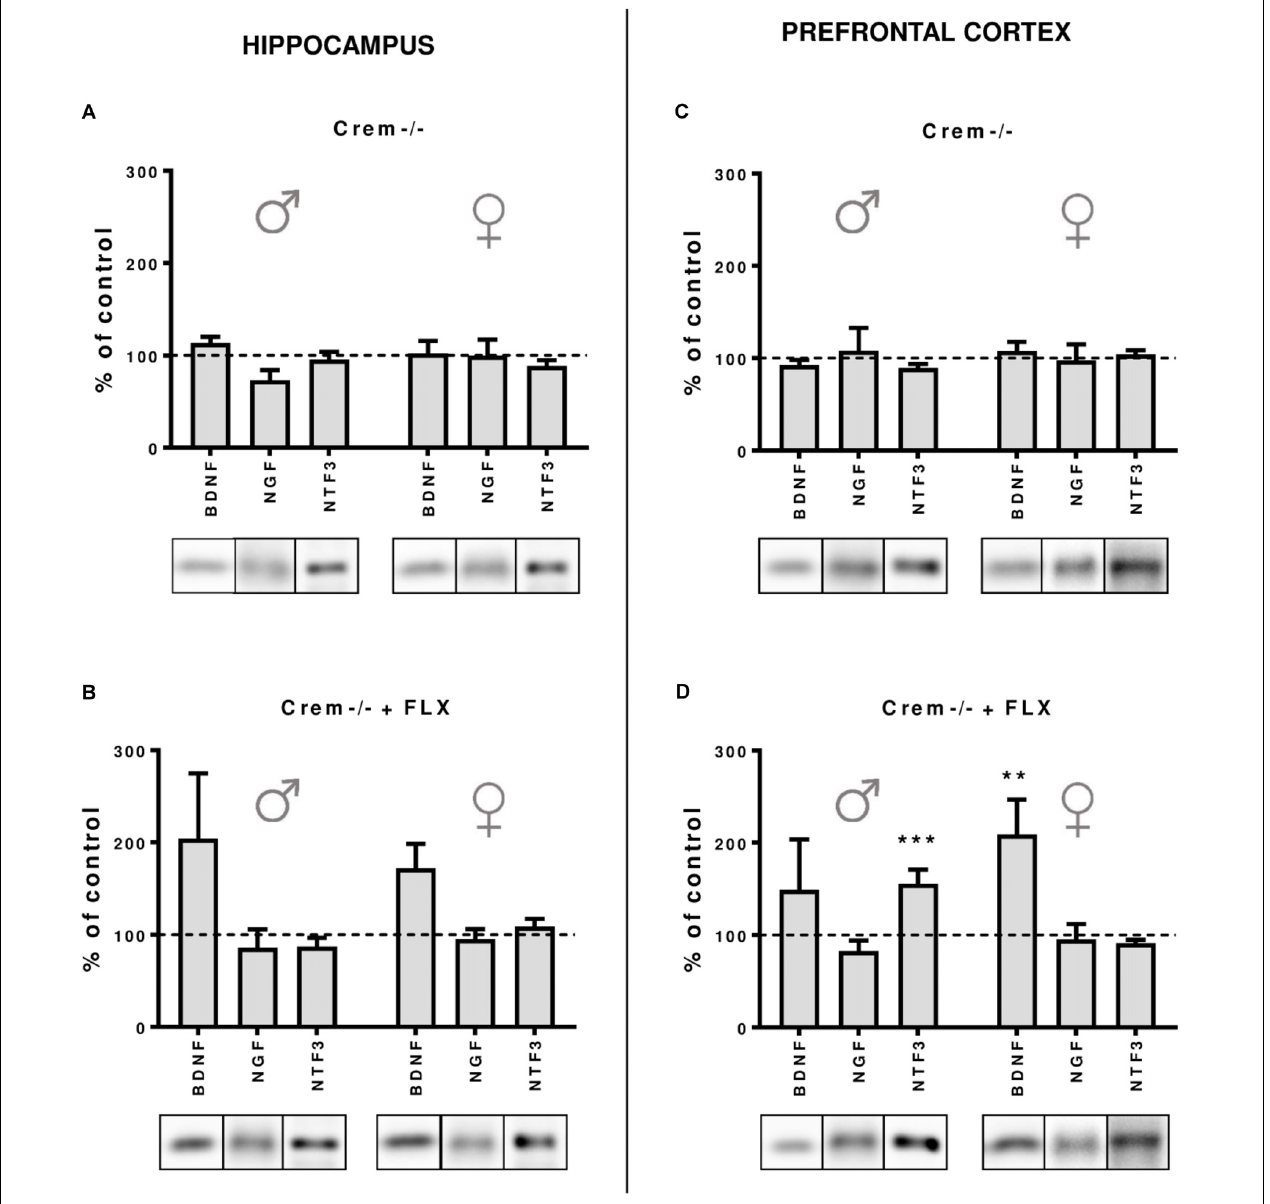
FIGURE 6 | Protein expression of BDNF, NGF and NTF3 after chronic fluoxetine administration in the hippocampus and PFC of wild-type and Crem–/– mice. CREM deletion did not cause any changes in neurotrophin levels in the hippocampus (A) or in the PFC (C) of male and female mutants. Fluoxetine administration increased BDNF levels in the PFC of females ( p < 0.01) (D) , and a similar tendency was observed in the hippocampus of both Crem–/– males and females. Additionally, fluoxetine increased NTF3 levels in the PFC of Crem–/– males. Western blot analyses of the effects of fluoxetine administration on the protein levels of BDNF,